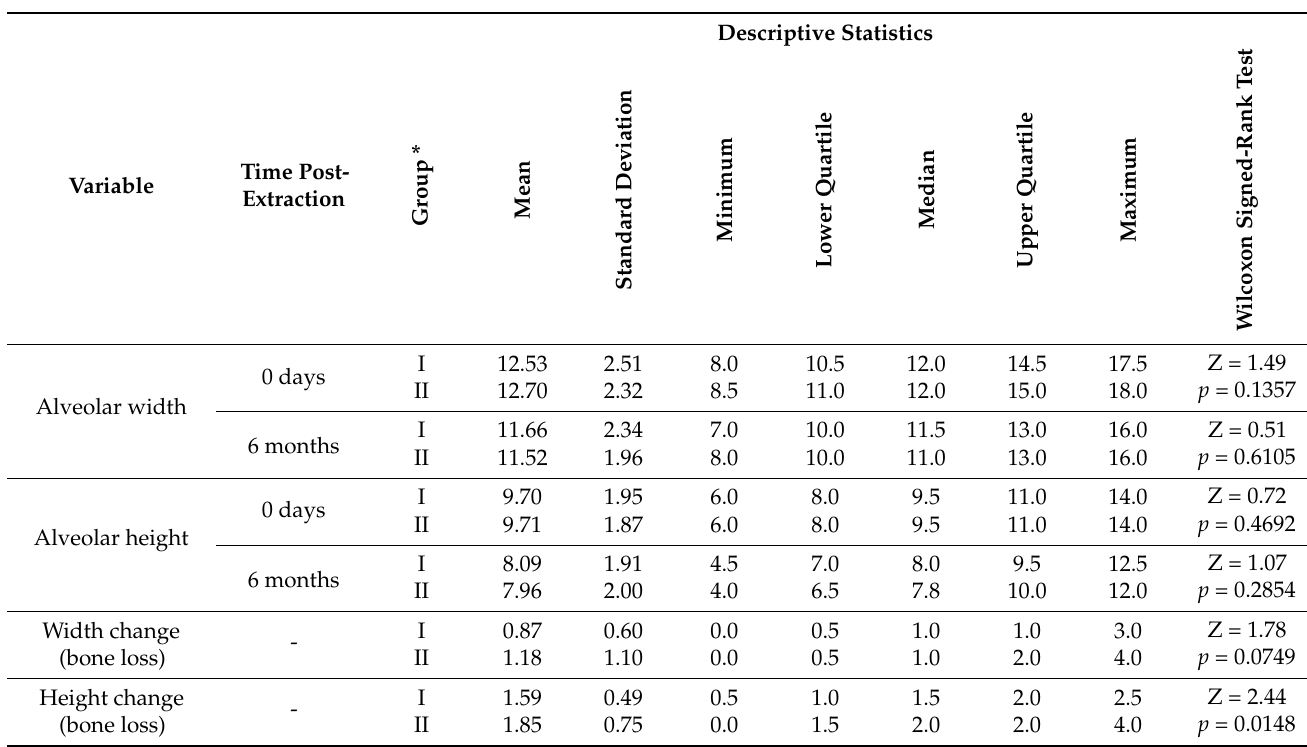
Table 5. Mean alveolar width and height 10 days and 6 months post-extraction (with and without PRF) and changes observed in CBCT